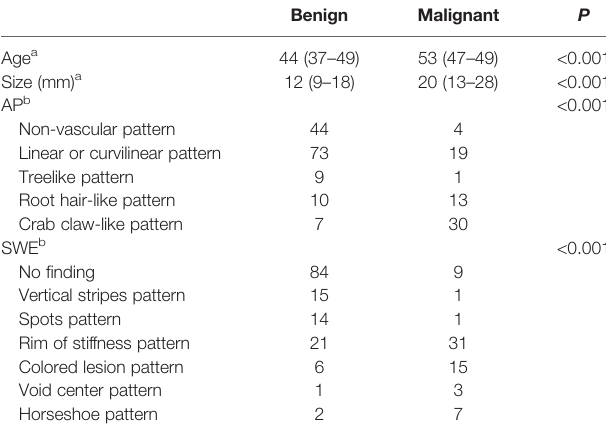
TABLE 2 | Comparison of qualitative SWE and AP features between benign and malignant lesions with pathological results.